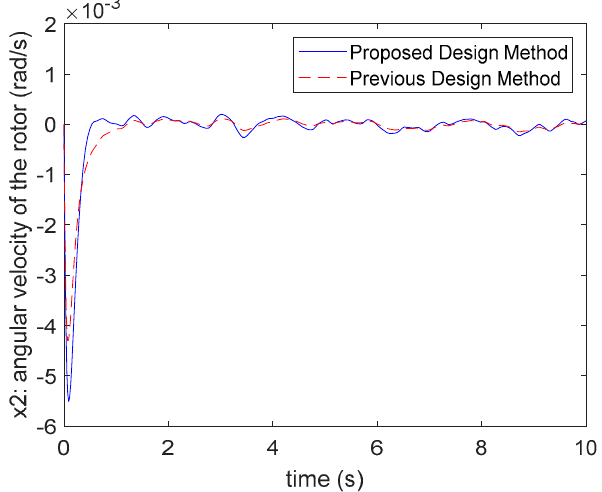
Figure 14. The comparison of state x 2 ( t ) . response with the method in [28].